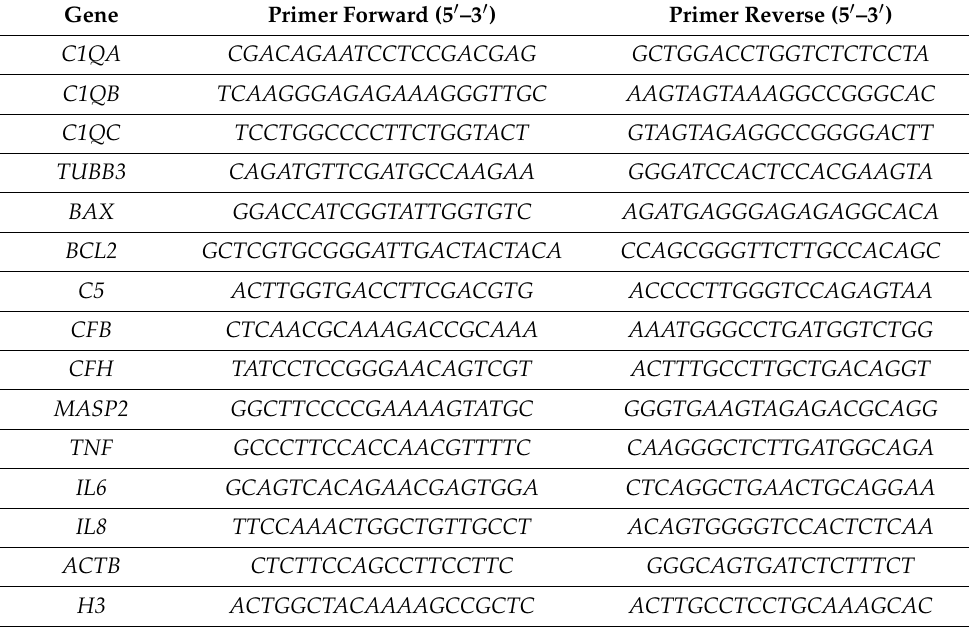
Table 2. Primer pairs used for RT-qPCR.